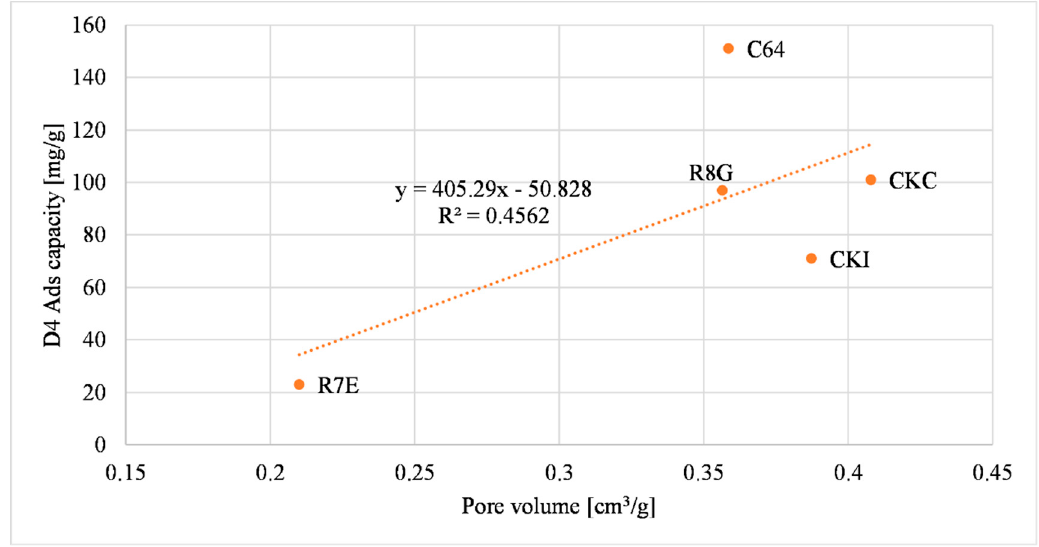
Figure 5. Total pore volume correlation with D4 adsorption capacity.